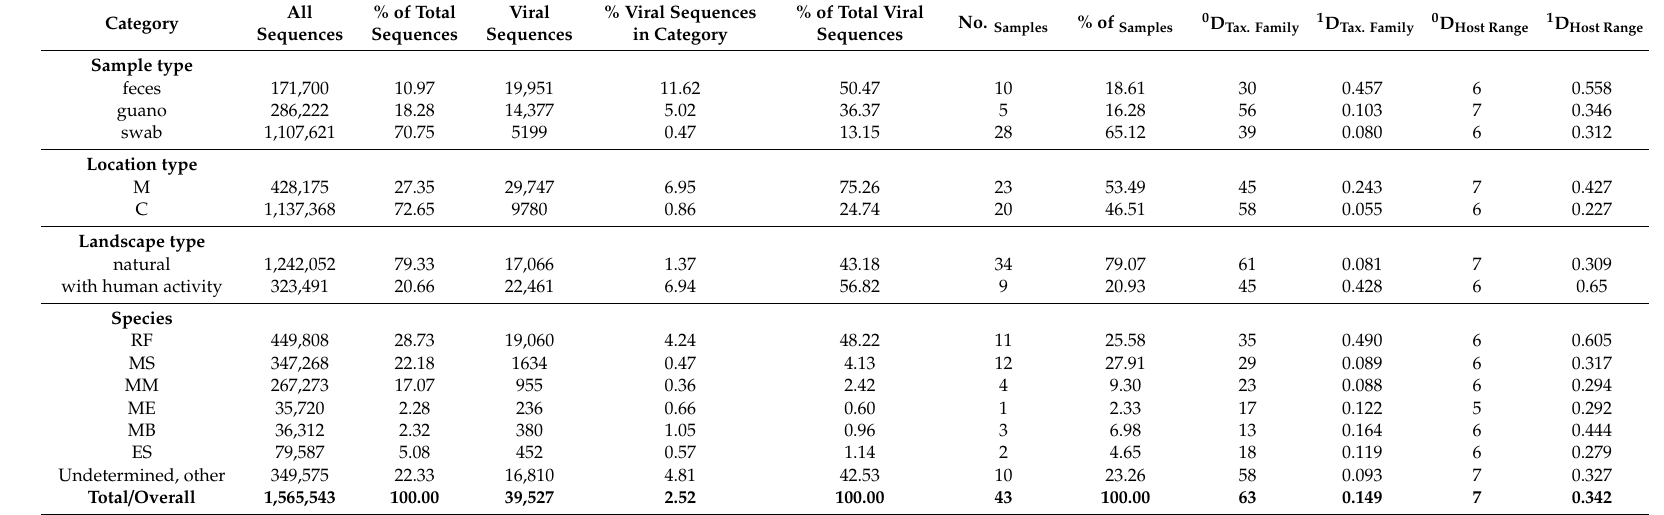
Table 1. Summary the sample data, stratified location groups (M—Mediterranean, C—continental), sample types, types of landscape, with total numbers of sequences, the numbers of viral sequences and the relevant proportions, and the zeroth- and first-order Hill diversity indices ( 0,1 D) based on taxonomy and host range. RF—